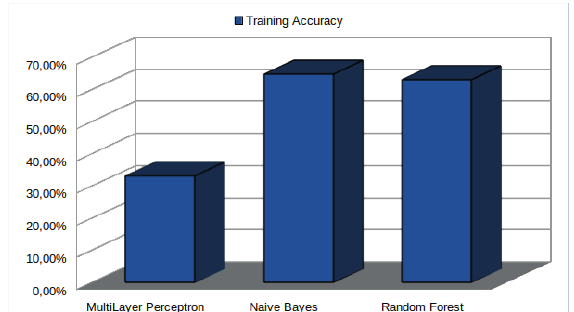
Figure 5. Training accuracy of the classifi ers.